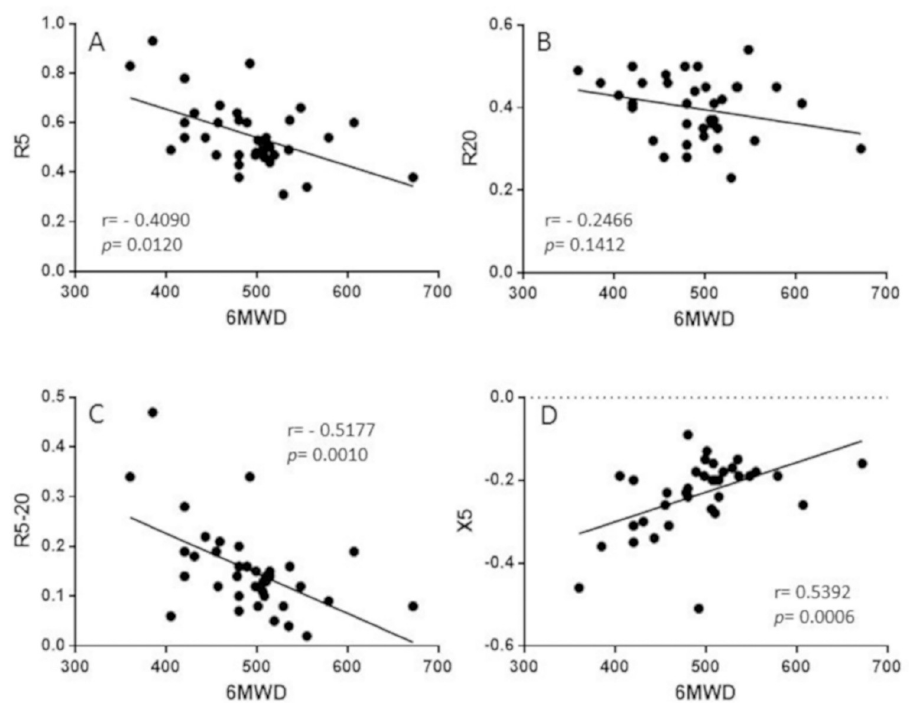
Fig 2. Correlation between impulse oscillometry and 6-minute walk distance (6MWD). A: correlation between R5 and 6MWD, B: correlation between R20 and 6MWD, C: correlation between R5-20 and 6MWD, D: correlation between X5 and